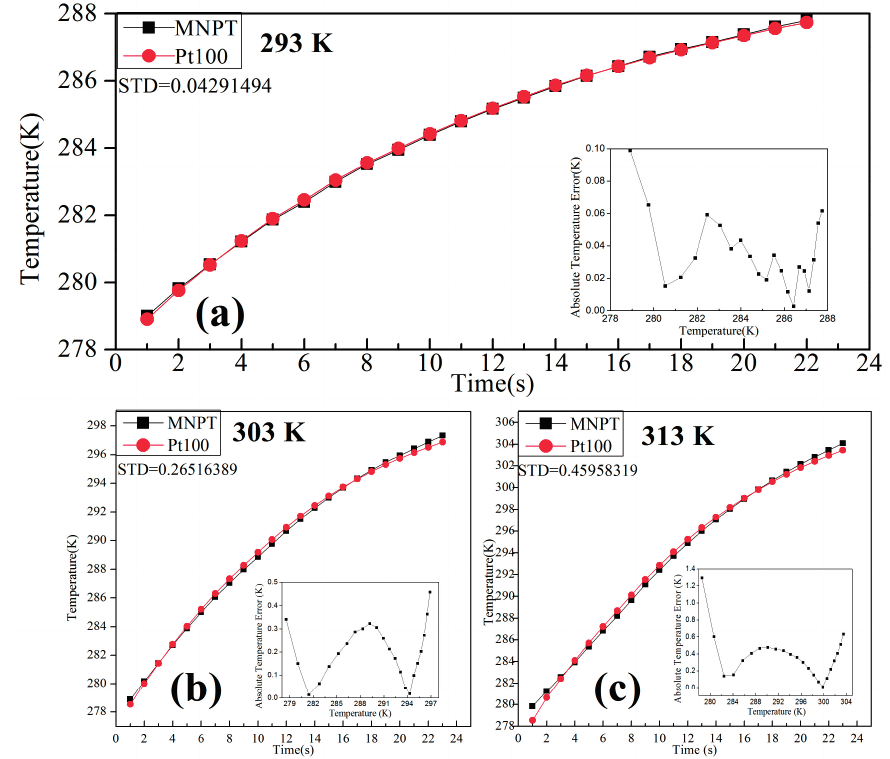
Figure 8. The error of the MNPT under different temperatures for the chambers. ( a – c ) represent different measurement error of the MNPT with respect to the temperatures for the chamber of 293 K, 303 K and 313